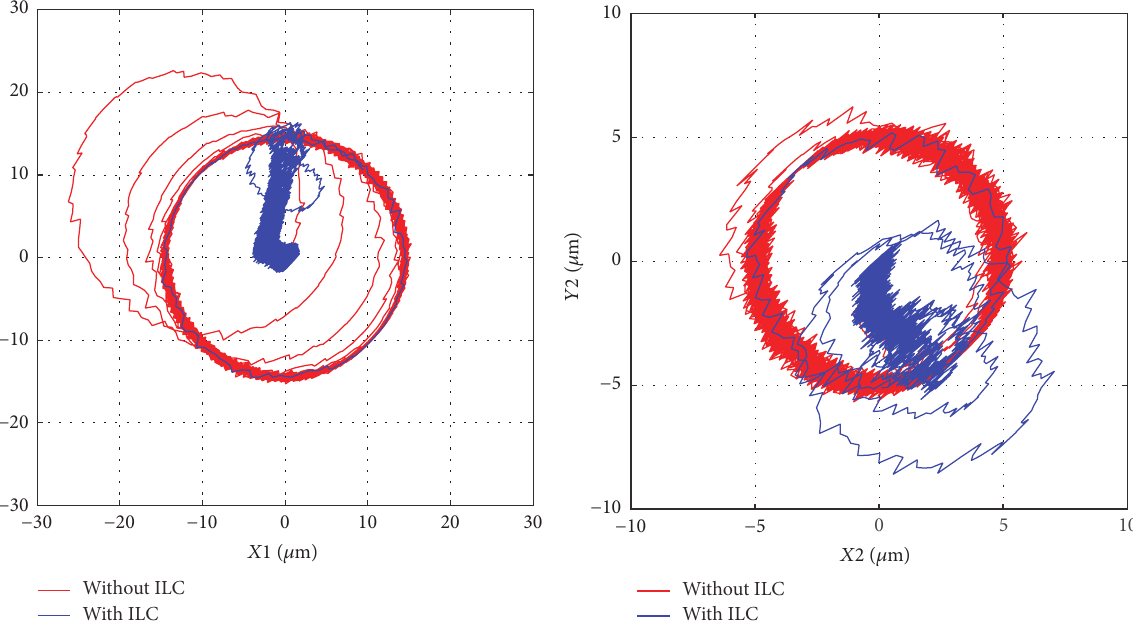
Figure 11: Orbits of the center of the shaft.